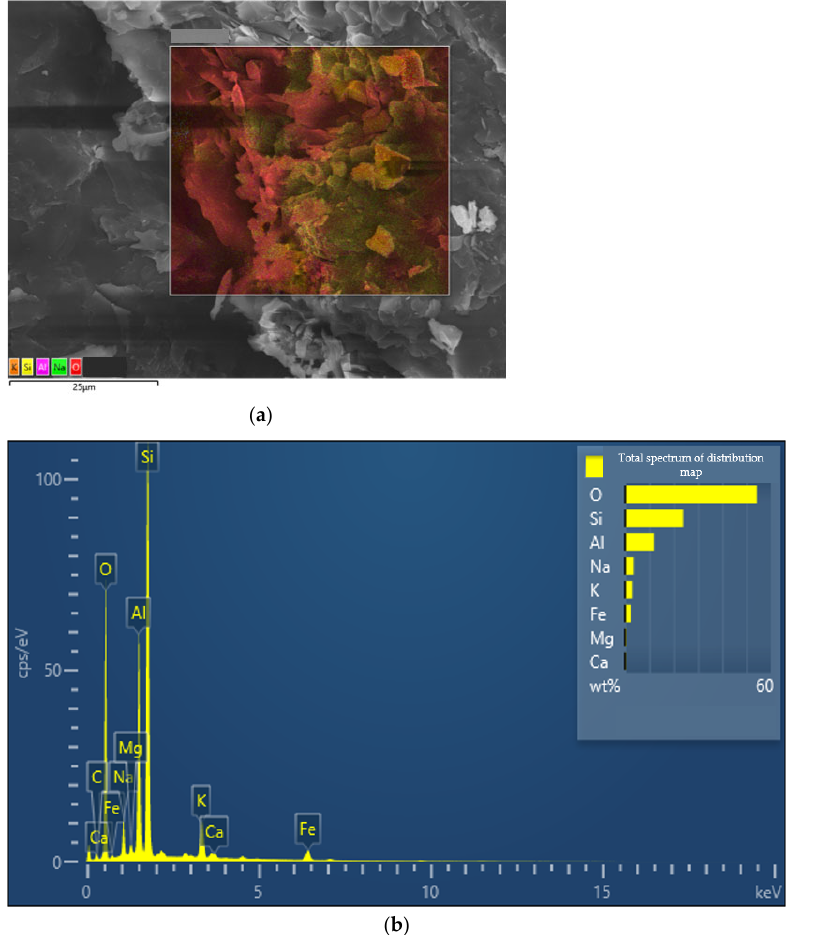
Figure 5. EDS energy spectrum analysis of metasandstone samples. ( a ) EDS image of constituent elements; ( b ) Total number spectrum of element distribution diagram of rock sample.